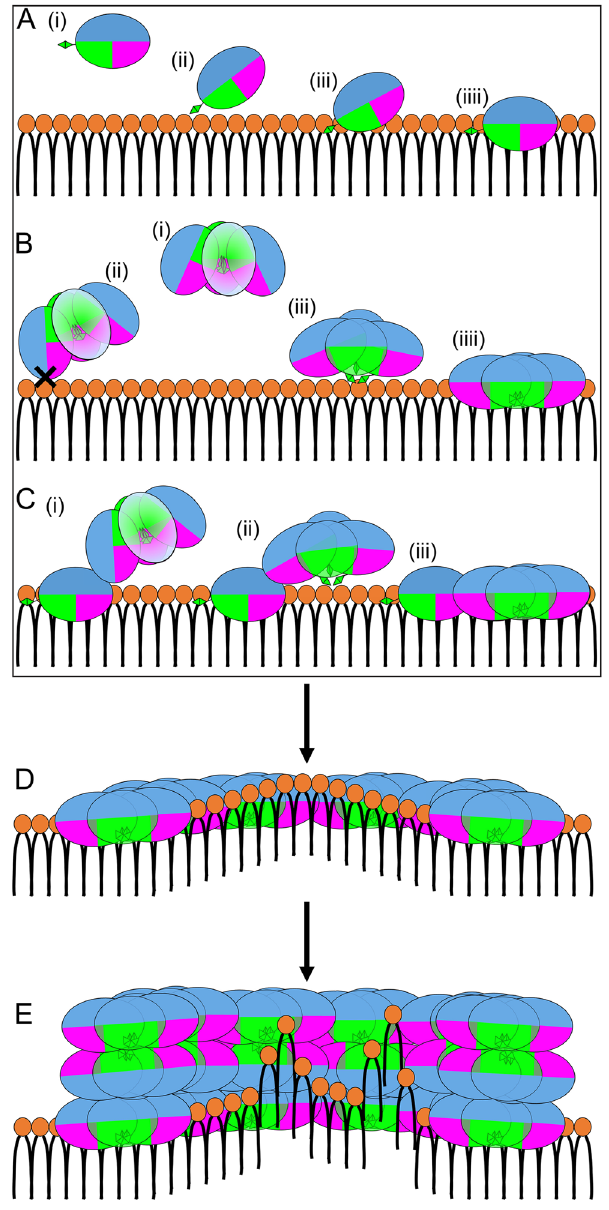
Figure 6. Mechanism of membrane binding and disruption by kB1. (A) The membrane binding mechanism of monomeric kB1. (i) Before the membrane binding process, Trp19 (extended green trapezoid) is exposed to the water. (ii) Membrane binding begins when Trp19 binds to the membrane. (iii) Hydrophobic residues in loop 5 (green patch) then bind to the membrane. (iiii) Next, hydrophobic residues in loops 5 and 6 (pink patch) bind to the hydrophobic region of the membrane while hydrophilic residues in loops 1, 2, 3 and 6 (blue patch) localize to water and the polar head region of the membrane. (B) The membrane binding mechanism of tetrameric kB1. (i) Loop 5 of one kB1 molecule interacts with loop 5 of other kB1 molecules to form a tetramer in the water. (ii) The tetramer cannot bind to the membrane when hydrophilic residues in loops 1, 2, 3 and 6 or hydrophobic residues in loop 6 reach the membrane. (iii) The tetramer binds to the membrane when Trp19 is exposed to water and is proximal to the membrane surface. (iiii) Hydrophobic residues in loop 5 then bind to the membrane. All hydrophobic residues in loop 6 then expand from the center of the tetramer and bind to the membrane. (C) The membrane binding of kB1 as a tower like cluster [29]. (i) Tetramer in the water bind to a monomer that is successfully bound to the membrane. (ii) In the tower-like cluster, the tetramer is held near the membrane surface. (iii) A wall-like cluster [29] is formed. (D) kB1 molecules do not